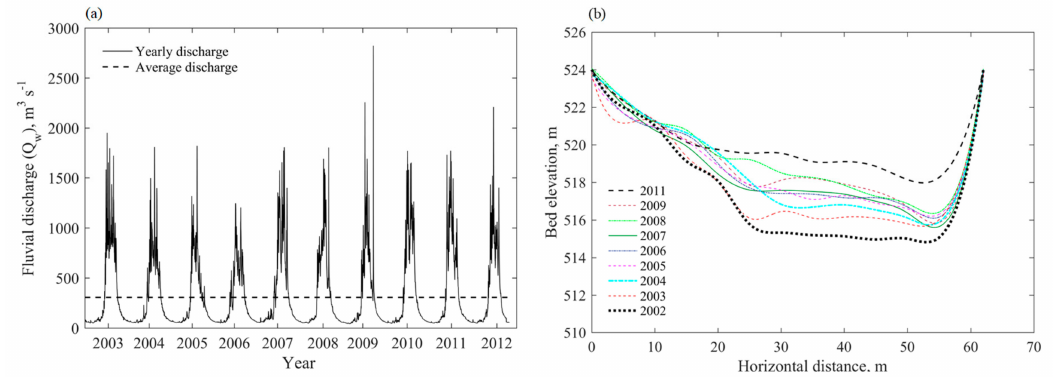
Figure 2. Yearly ( a ) discharge (NEA 200–2012) ( b ) cross profiles (2002–2011) of Kali Gandaki River.